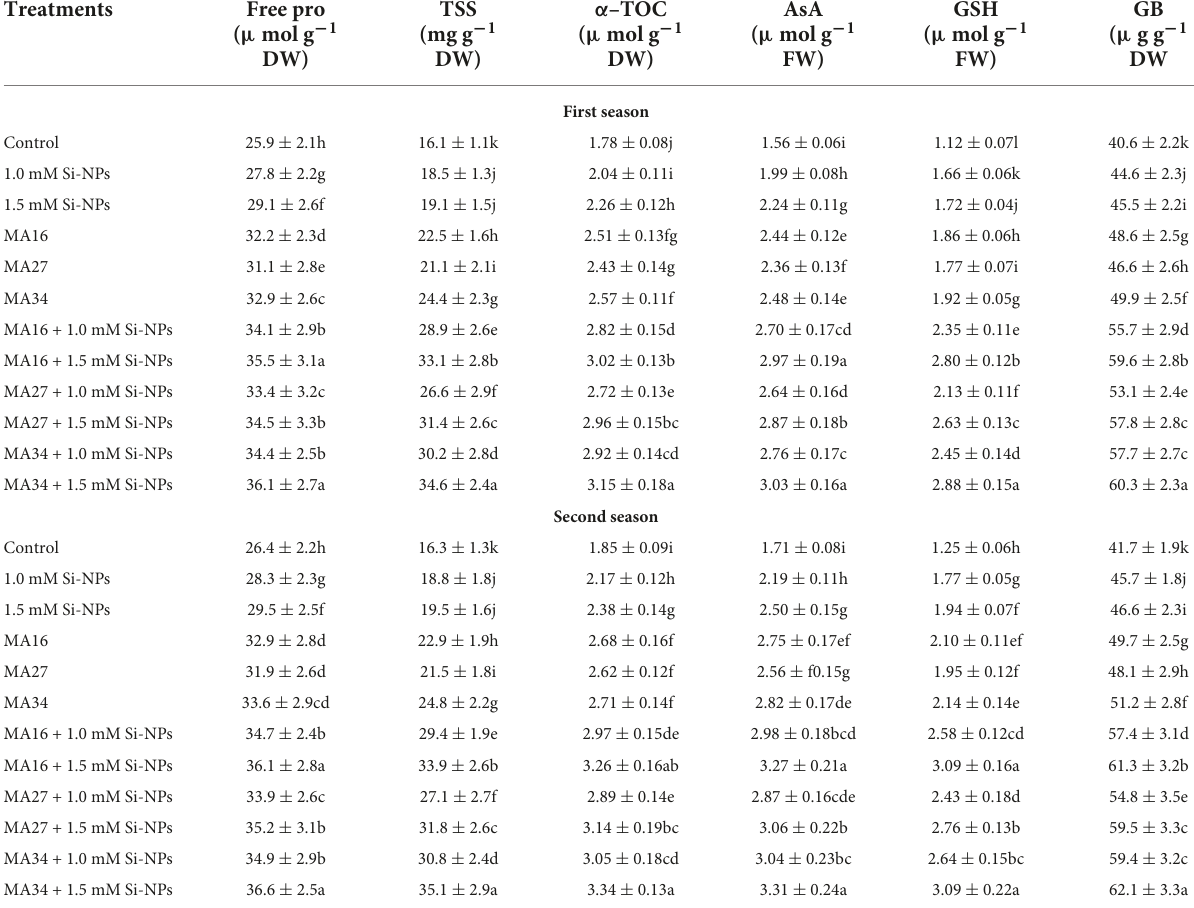
TABLE 6 Effect of soil application with calcium carbonate precipitating bacteria (CCPB), Bacillus lichenforms (MA16), Bacillus megaterium (MA27), and Bacillus subtilis (MA34), and foliar application with silicon nanoparticles (Si-NPs) on osmoprotectants contents (free Pro and TSS), α -TOC, AsA, GSH and glycine betaine of wheat plants (cv. Misr